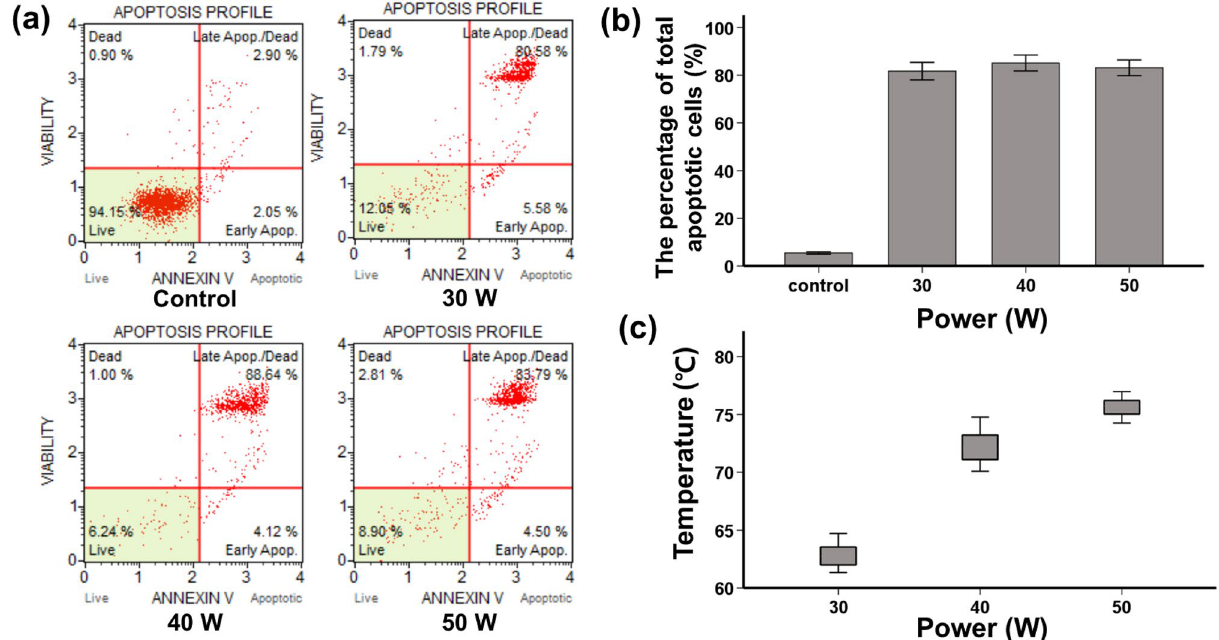
Figure 2. Radiofrequency (RF) ablation using a stent-based electrode in gastric cancer cells to verify apoptotic effects. ( a ) Reduction in the viable cell number was determined using an annexin V assay. ( b ) Graph showing the total quantity of apoptotic cancer cells (early + late apoptotic cells). ( c ) Maximum temperature in accordance with the power setting used for the RF